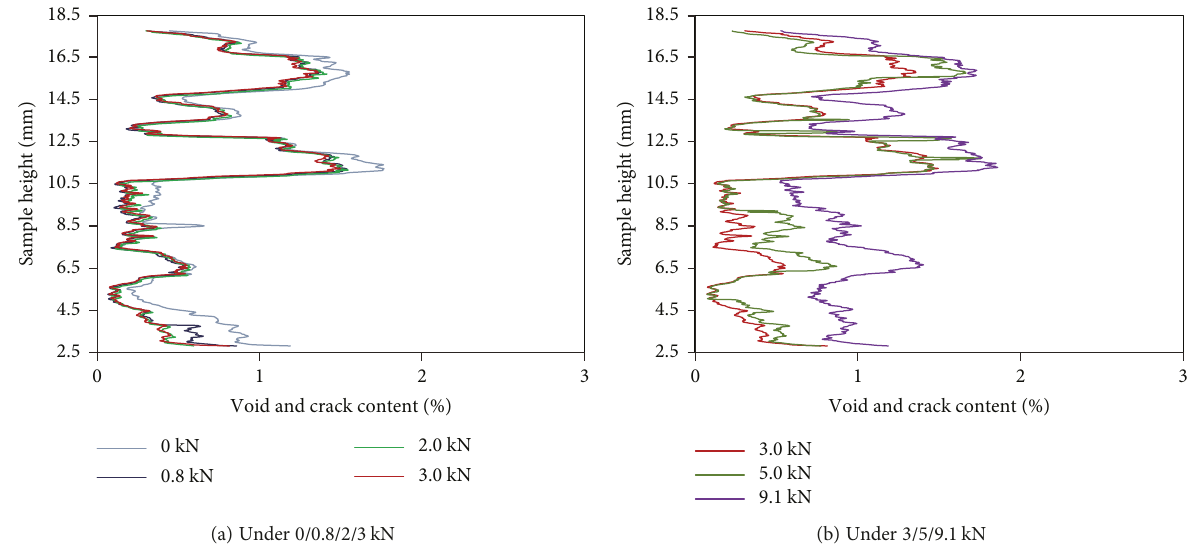
Figure 7: The content of voids and cracks along the specimen height direction throughout loading